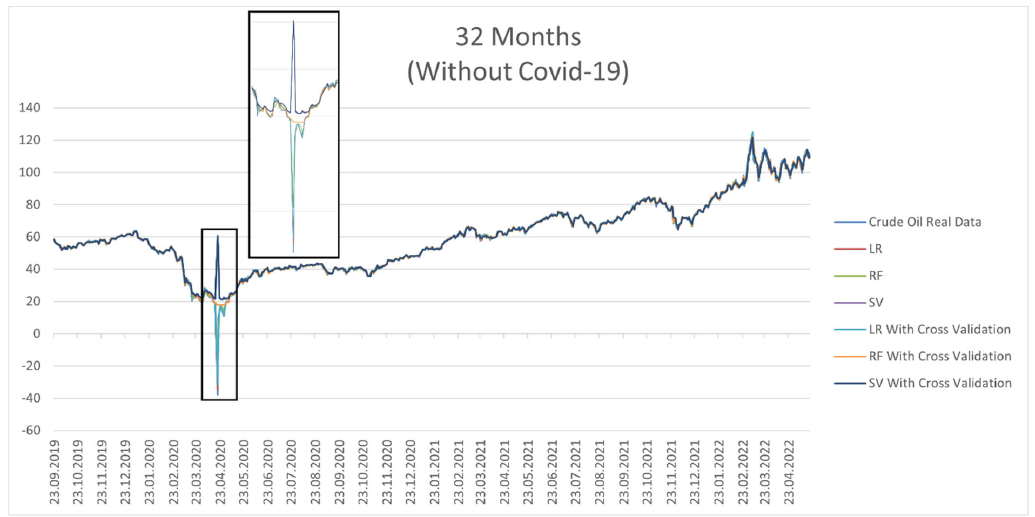
Figure 8. Results for thirty ‐ two months without the effect of COVID ‐ 19. Table 3. Performance results using machine